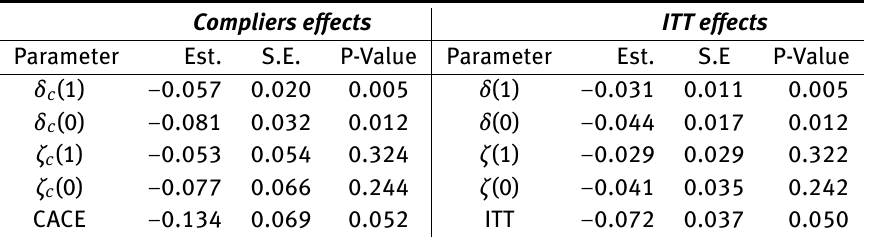
Table 2: Estimates of the mediated and unmediated ITT